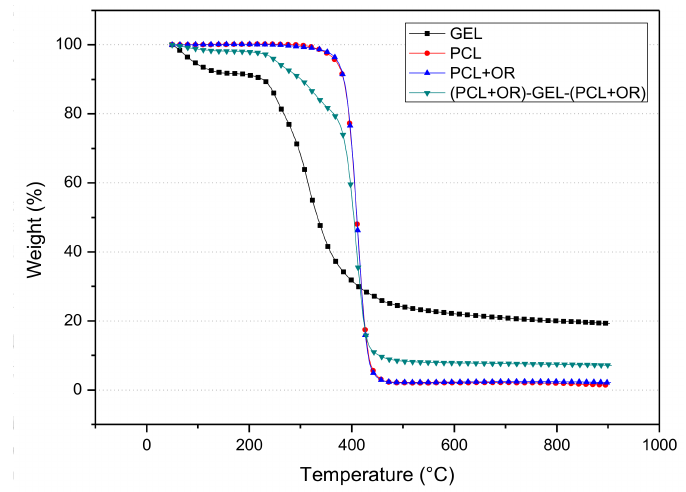
Figure 5. TGA curves of GEL, PCL, PCL+OR, and (PCL+OR)-GEL-(PCL+OR)